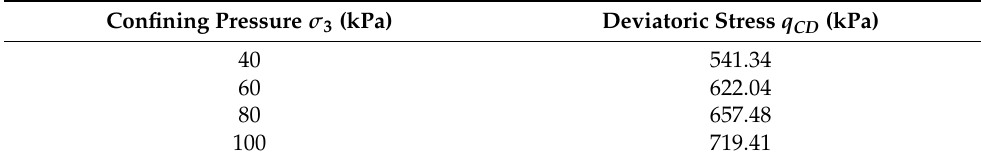
Figure 7. Mohr circles of CD tests on calcareous sand under different confining pressures. Table 1. Maximum deviatoric stress on calcareous sand under different confining pressures using tri-axial CD tests.